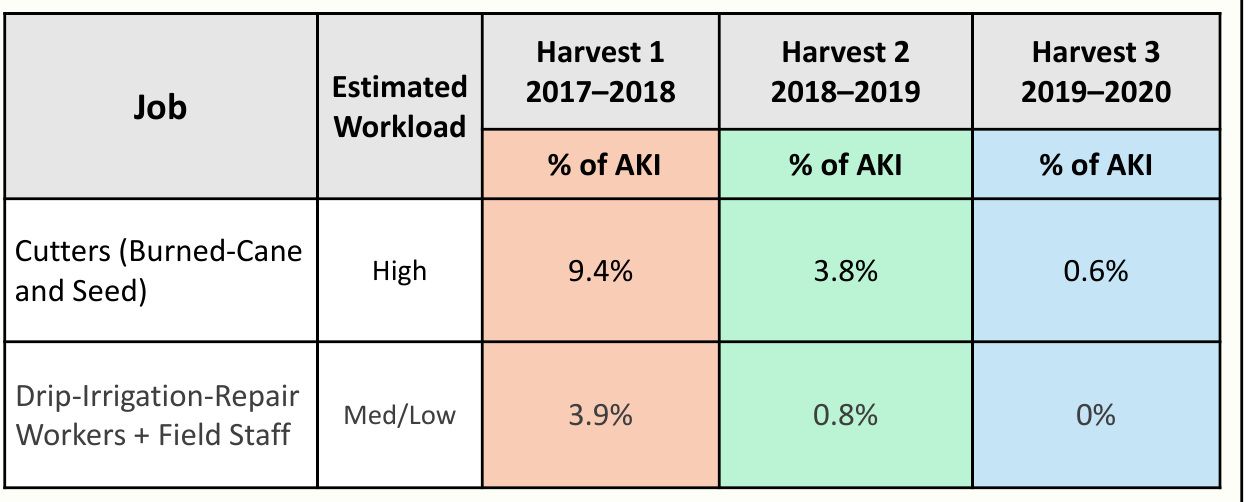
Figure 3. Incidence of hospitalized acute kidney injury (AKI) across three harvests. Percentages based on all sugarcane workers active in each job